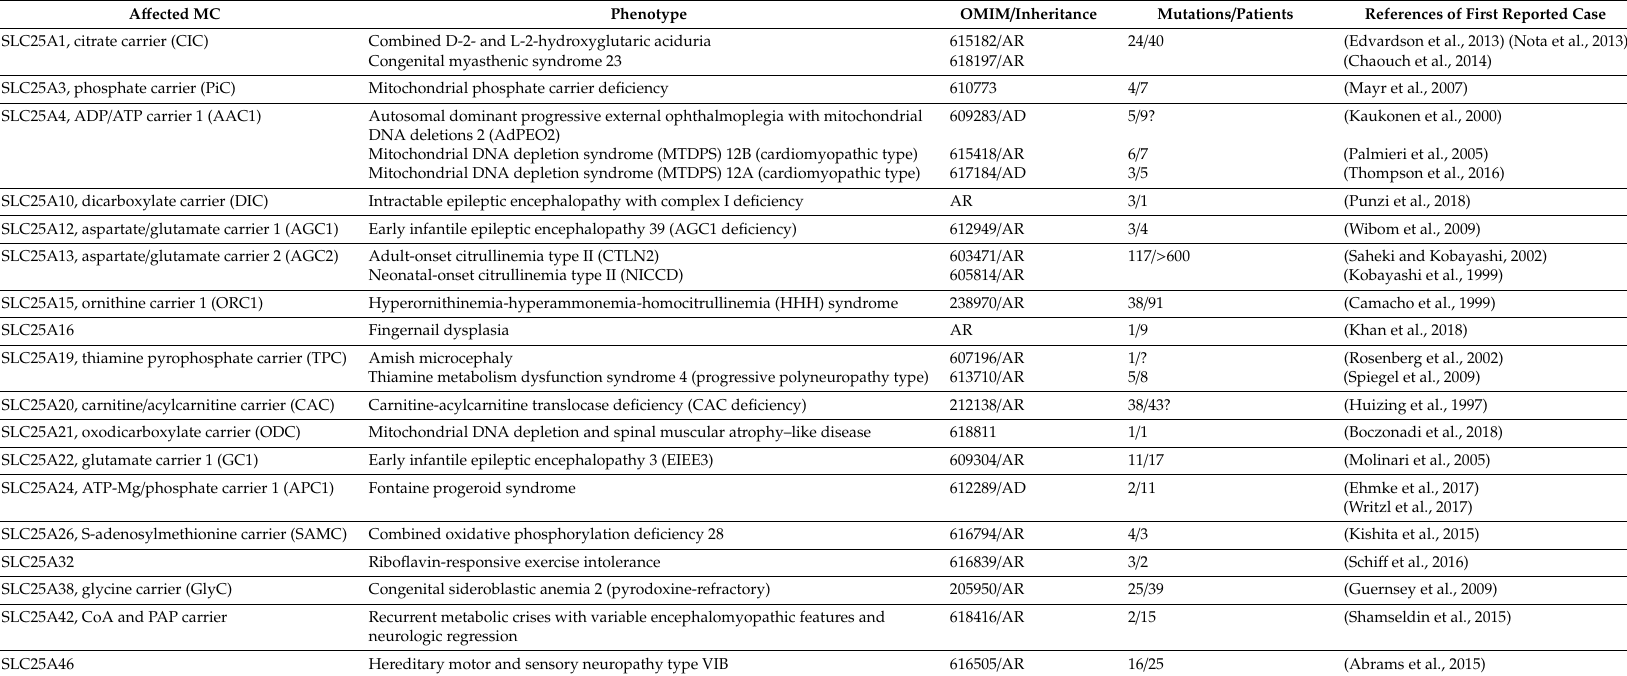
Table 1. Diseases caused by mutations in mitochondrial carrier